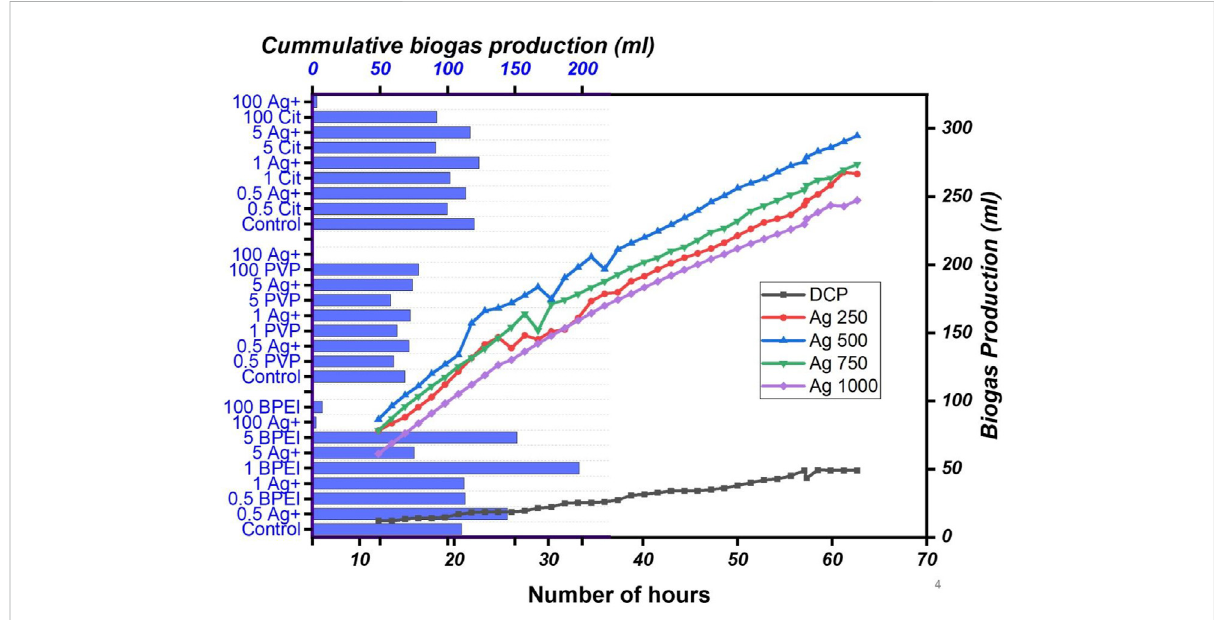
FIGURE 7 Biogas production for different concentrations of Ag NPs (Ün ş ar et al., 2016) and Cumulative biogas production (horizontal bar) resulted in different concentrations of Ag NPs or Ag + (Gitipour et al.,